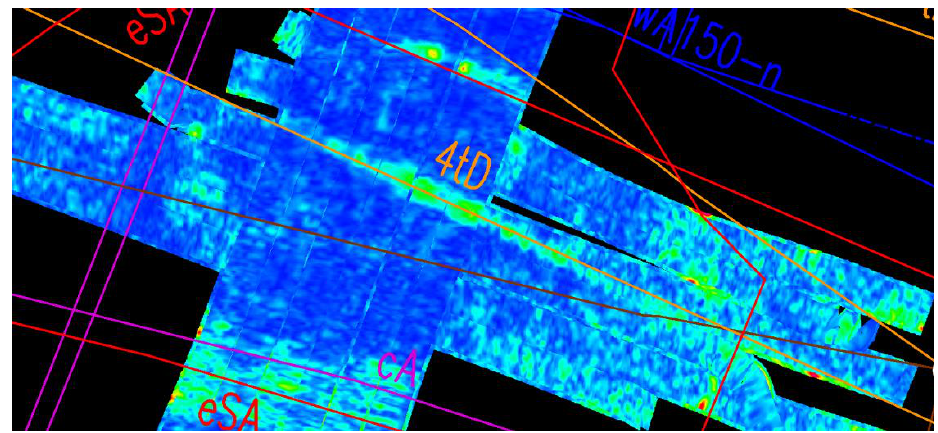
Figure 15. Consistency of GPR data on the intersection of two perpendicular areas A and B on an example of a telecommunication network.